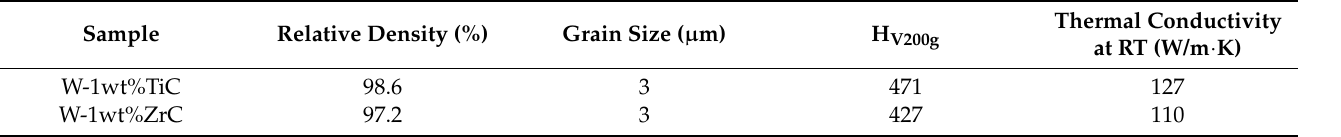
Figure 4. SEM images showing fracture surface morphology of ( a ) W-1wt%TiC, ( b ) W-1wt%ZrC. Table 1. Relative density, grain size, microhardness, and thermal conductivity at RT of W-1wt%TiC and W-1wt%ZrC sintered by SPS.